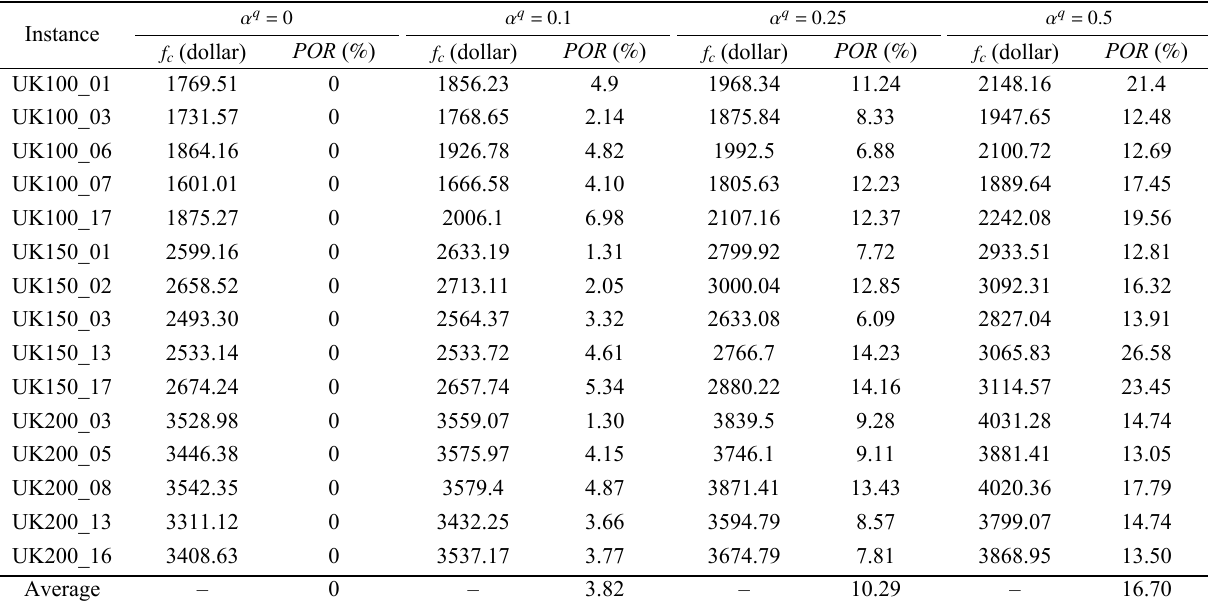
Table 6 Fixed α q =0.1, the solution cost when θ